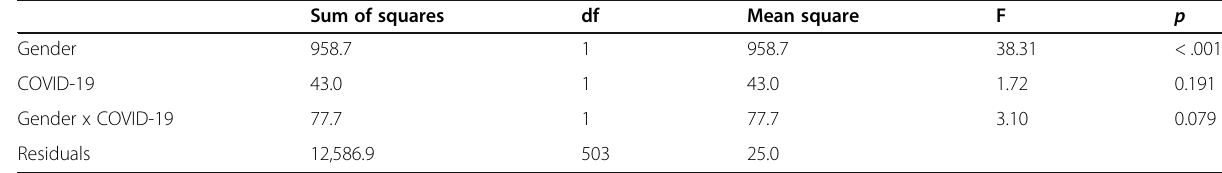
Table 5 Analysis of variance (ANOVA) of the effect of gender and COVID-19 infection on the scores of GAD-7 Sum of squares df Mean